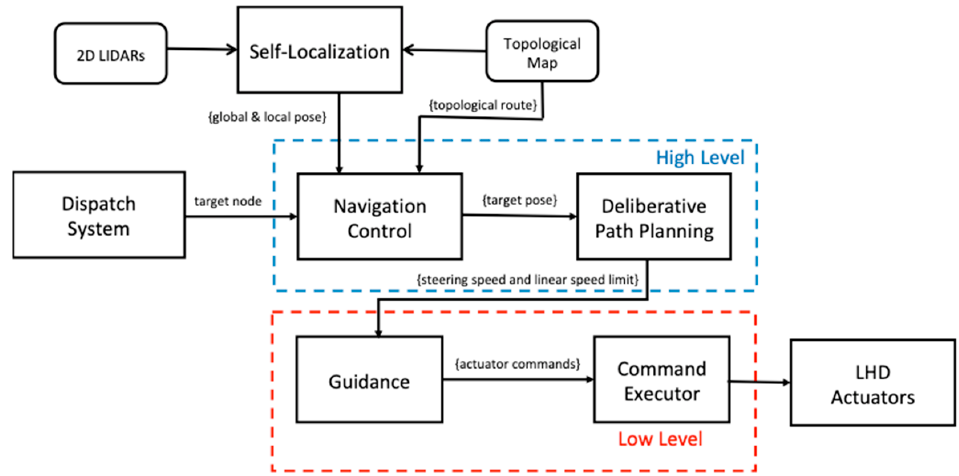
Figure 9. Diagram of the navigation system.